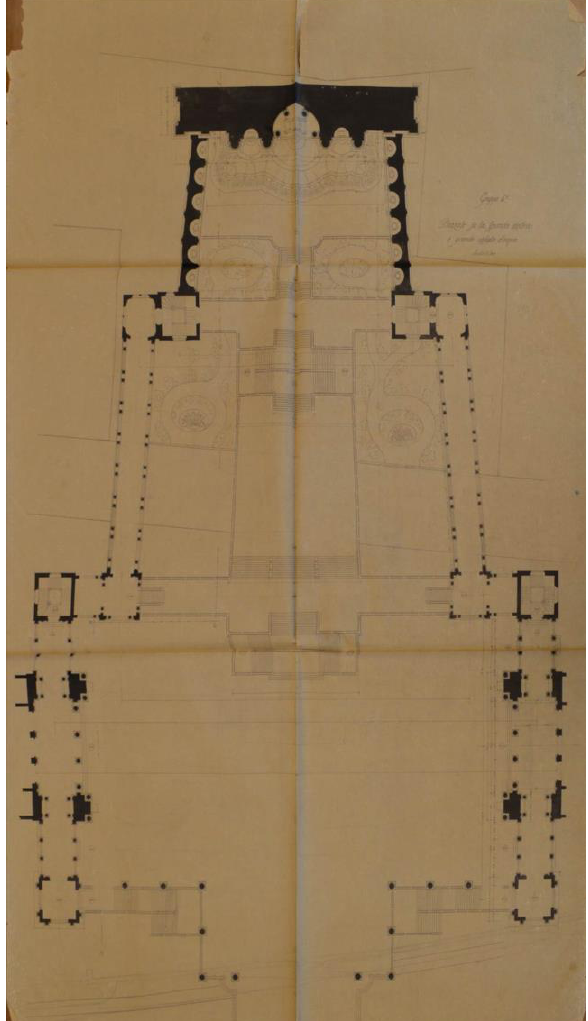
Figure 6. Plan of the Monumental Waterfall and Courtyard of Honour, original scale 1:100 (Fondazione Marazza, Archivio Stefano